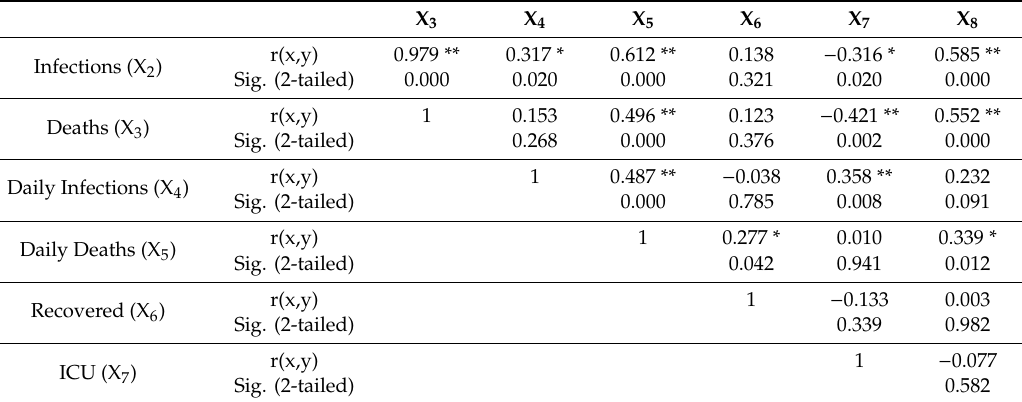
Table 1. Results of Pearson’s bivariate correlation analysis (r) a